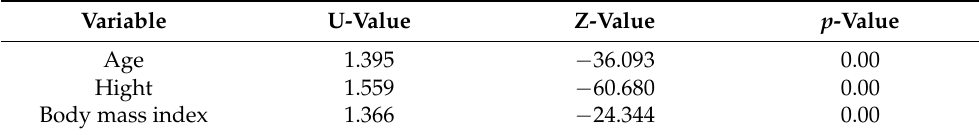
Table 6. The Mann-Whitney U test results for CoM vertical